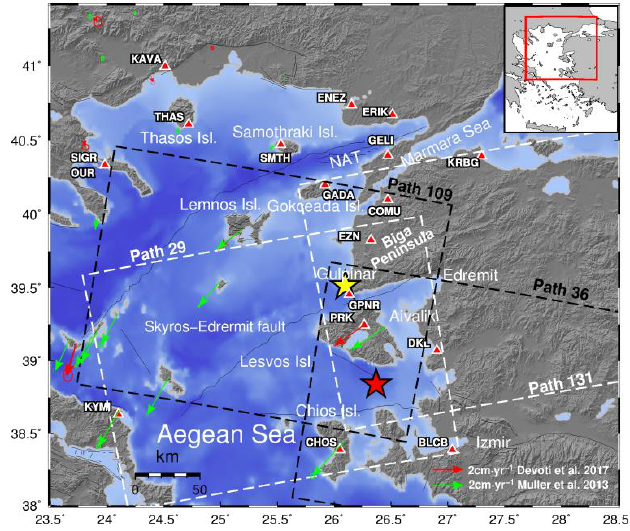
Figure 1. Map of Northeast Aegean Sea and northwestern Anatolia. The yellow star shows the location of the February 2017 Gulpinar-Babakale seismic sequence. Red triangles indicate the location of the broadband seismic stations that provided phase data for relocation of seismicity. Vectors indicate GPS velocities (red after [1]; green after [2]) represented with respect to stable Europe. NAT stands for North Aegean Trough. Thin black lines are traces of major faults from the NOAFaults database [3]. Red star indicates the NOA epicentre of the M6.3 12 June 2017 earthquake south of Lesvos. Boxes with dashed boundaries indicate the frames of the Sentinel-1 satellite SAR images used (white-ascending, black-descending). Table 1. January to March 2017 NOA location and moment tensor parameters of earthquakes of M w ≥ 3.6 in the Gulpinar-Babakale area (NW Turkey). The four main events, with M w ≥ 5.0, are shown in bold (no 3, 4, 6 and 15 in column 1). Details on the MT solutions can be found online at http://bbnet.gein.noa.gr/HL/seismicity/mts/revised-moment-tensors.